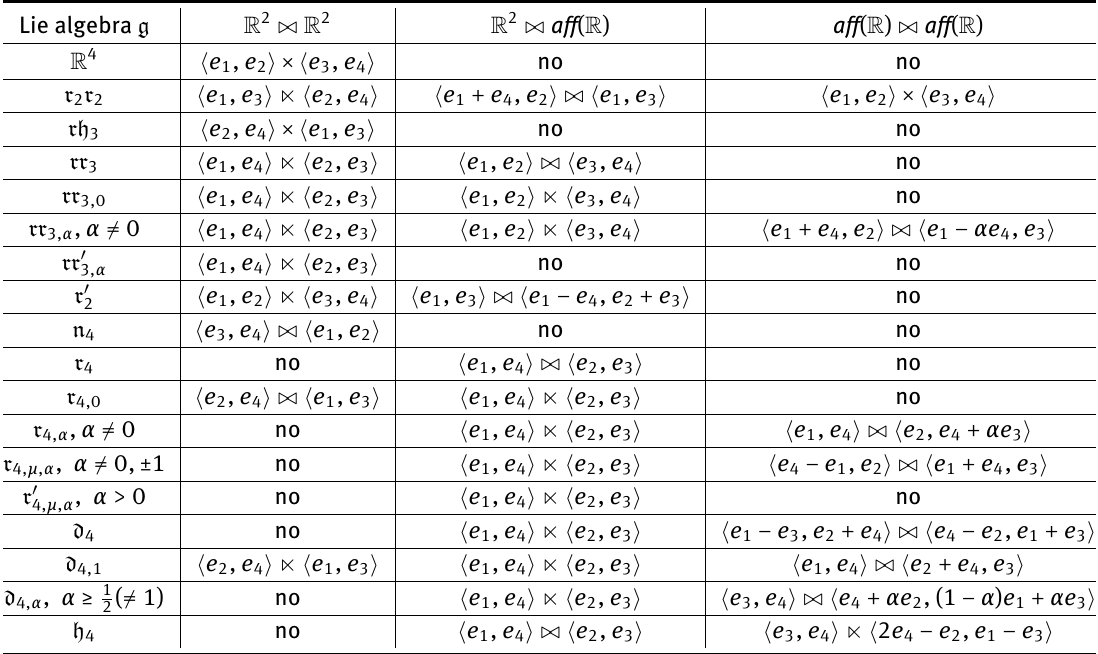
Table 2: Four-dimensional paracomplex Lie